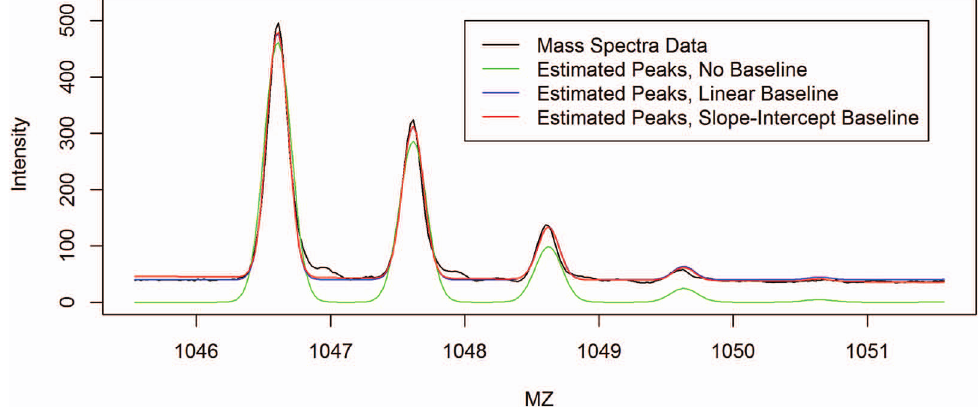
Figure 1. Different methods used for fitting a single peptide isotopic cluster to a MALDI-TOF spectrum of unlabeled Angiotensin II. The inclusion of a slope-intercept form baseline (red estimation) increases the fit over a flat baseline (blue estimation). Both of which are better than not including a baseline (green estimation).